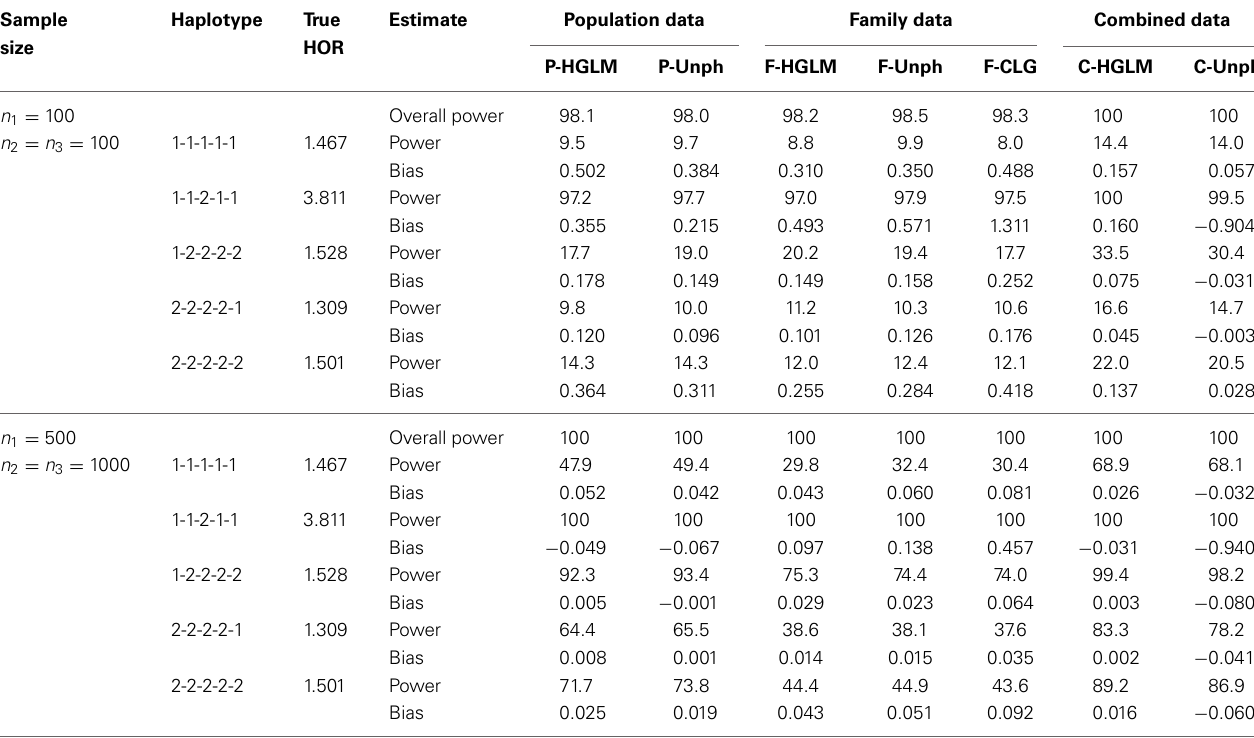
Table 3 | Power (%) at 5% significance level and bias for the 5-locus model under varying sample size. The reference haplotype is 1-2-1-2-2. Sample Family data